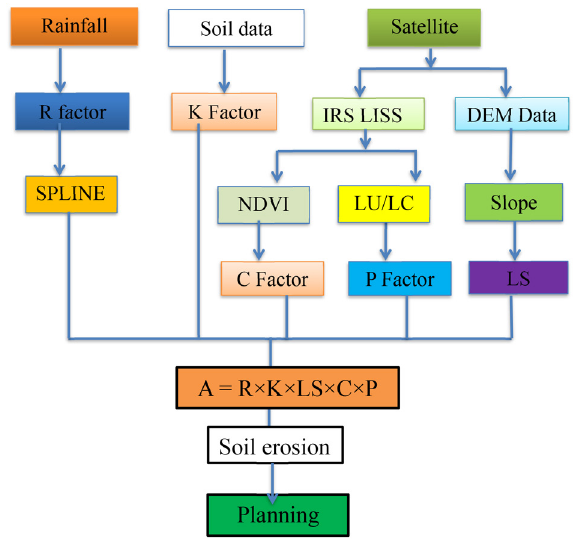
Figure 4. Work flow of